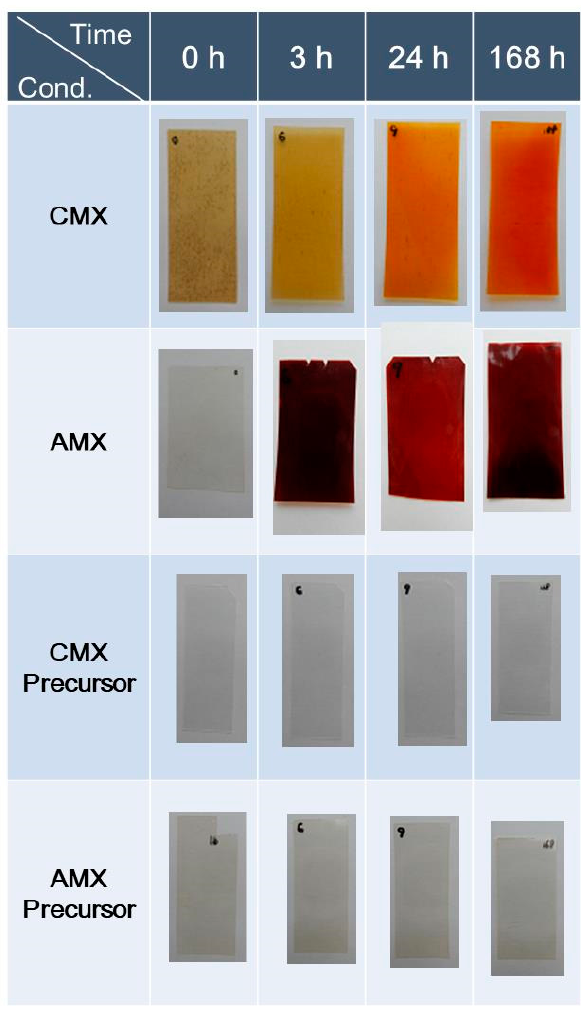
Figure 9. Color change in various test pieces with respect to 6 M NaOH concentration and varied immersion time periods (40 °C).